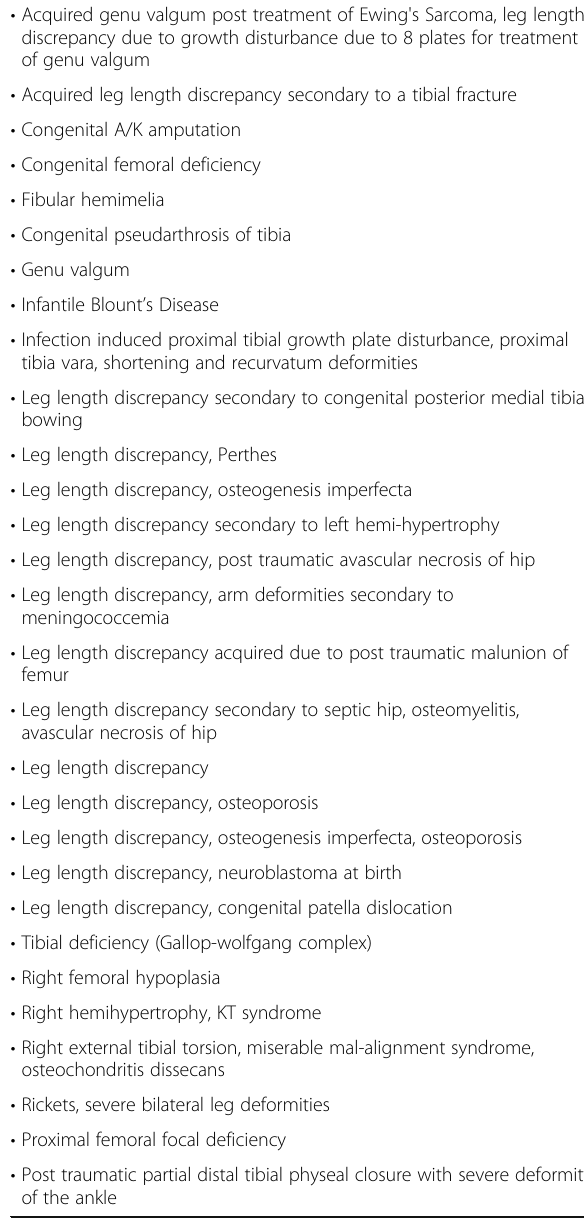
Table 2 List of deformities included in the study